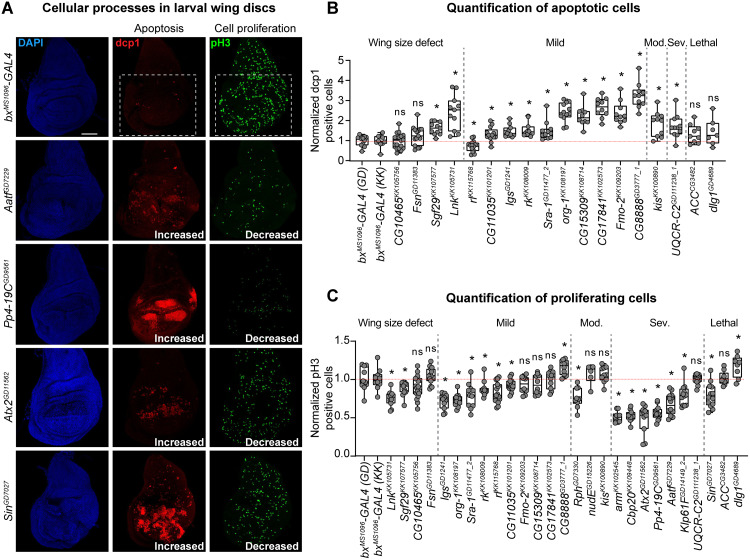
Drosophila homologs of CNV and neurodevelopmental genes show altered levels of apoptosis and proliferation.(A) Larval imaginal wing discs (scale bar = 50 μm) stained with nuclear marker DAPI, apoptosis marker dcp1, and cell proliferation marker pH3 illustrate altered levels of apoptosis and cell proliferation due to wing-specific knockdown of select fly homologs of CNV genes. We quantified the number of stained cells within the wing pouch of the wing disc (white box), which becomes the adult wing. Additional representative images of select homologs are presented in S5 and S6 Figs. Genotypes for the wing images are: w1118/bxMS1096-GAL4;+; UAS-Dicer2/+, w1118/bxMS1096-GAL4;+; UAS-AatfGD7229
RNAi/UAS-Dicer2, w1118/bxMS1096-GAL4;UAS-Pp4-19CGD9561RNAi/+; UAS-Dicer2/+, w1118/bxMS1096-GAL4;+; UAS-Atx2GD11562
RNAi/UAS-Dicer2, and w1118/bxMS1096-GAL4;+; UAS-SinGD7027
RNAi/UAS-Dicer2. (B) Boxplot of dcp1-positive cells in larval wing discs with knockdown of select fly homologs of CNV and neurodevelopmental genes, normalized to controls, is shown (n = 7–18, *p < 0.05, two-tailed Mann–Whitney test with Benjamini-Hochberg correction). We note that several RNAi lines showed severe dcp1 staining across the entire wing disc and could not be quantified. (C) Boxplot of pH3-positive cells in the larval wing discs with knockdown of select fly homologs of CNV and neurodevelopmental genes, normalized to controls, is shown (n = 6–18, *p < 0.05, two-tailed Mann–Whitney test with Benjamini-Hochberg correction). Boxplots are organized by adult wing phenotype (wing size defect, mild, moderate (mod.), severe (sev.), lethal). Boxplots indicate median (center line), 25th and 75th percentiles (bounds of box), and minimum and maximum (whiskers), with red dotted lines representing the control median.